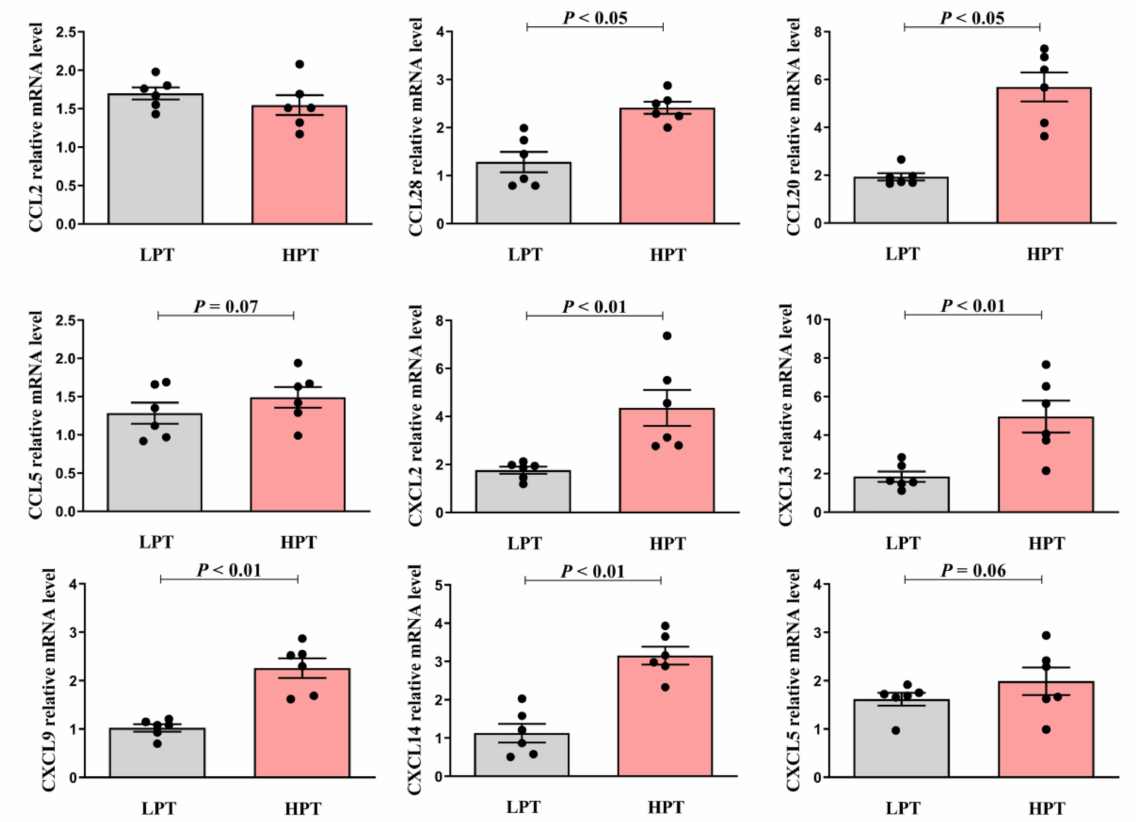
Figure 3. Effects of low and high NFC to NDF ratio pelleted TMR on mRNA level of chemokines in